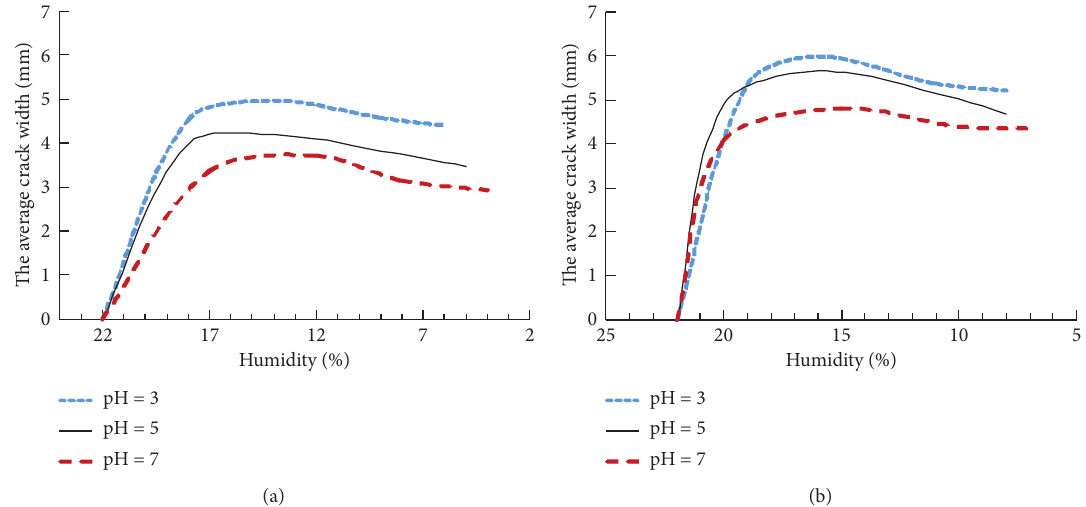
Figure 8: The average crack width under cyclic drying-wetting samples during the dehumidification process. (a) One-time cyclic drying- wetting. (b) Four-times cyclic